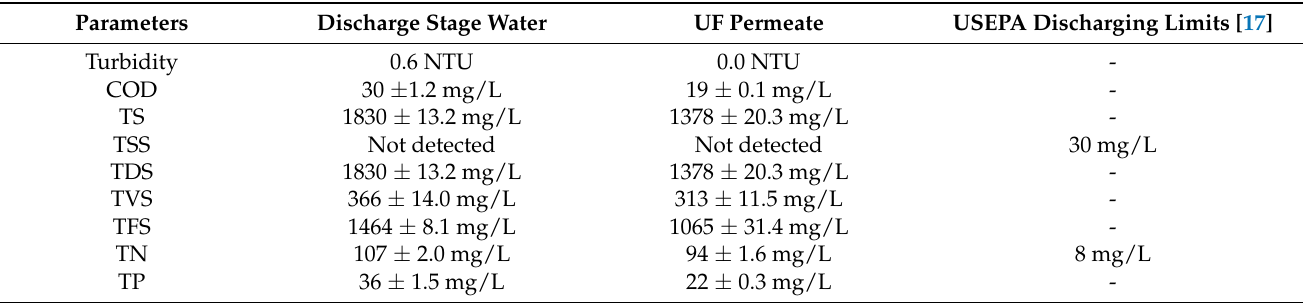
Table 5. PSWW characterization at the discharge stage and after UF